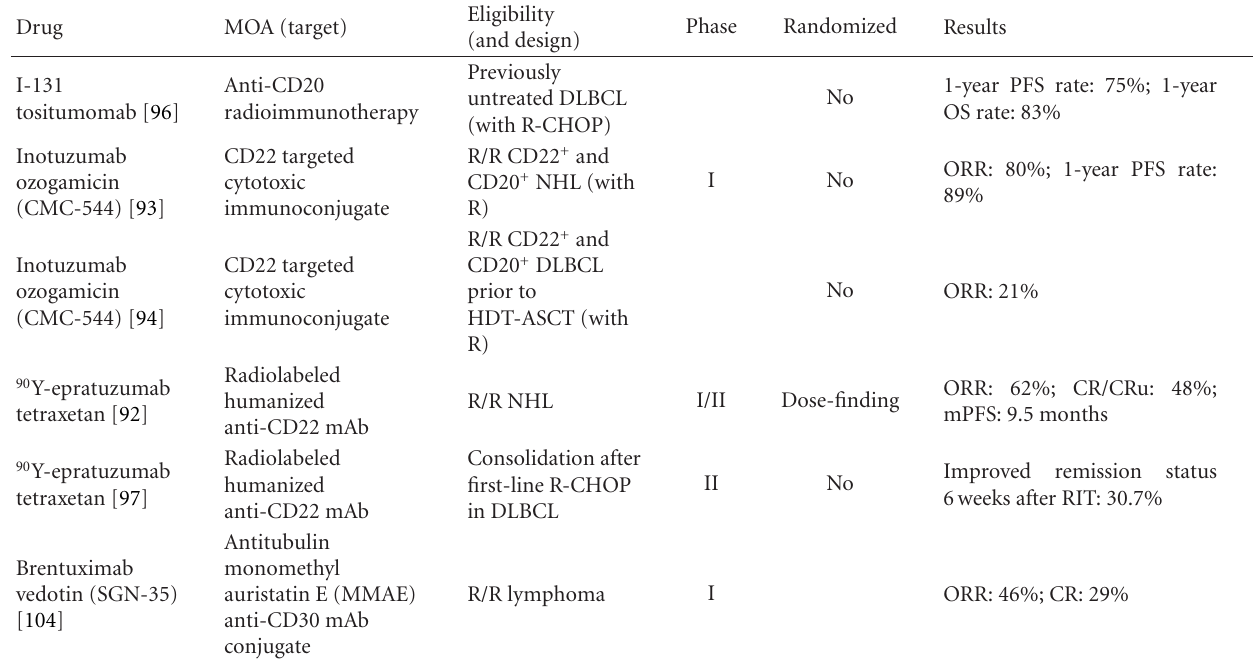
Table 3: Antibody-drug conjugates and radiolabeled antibodies in clinical development for the treatment of aggressive NHL. [CR: complete response; CRu: unconfirmed CR; DLBCL: di ff use large B-cell lymphoma; HDT-ASCT: high-dose therapy/autologous stem cell transplanta- tion; mAb: monoclonal antibody; MOA: mechanism of action; mPFS: median progression-free survival; NHL: non-Hodgkin lymphoma; ORR: overall response rate; OS: overall survival; PFS: progression-free survival; R: rituximab; R-CHOP: cyclophosphamide,